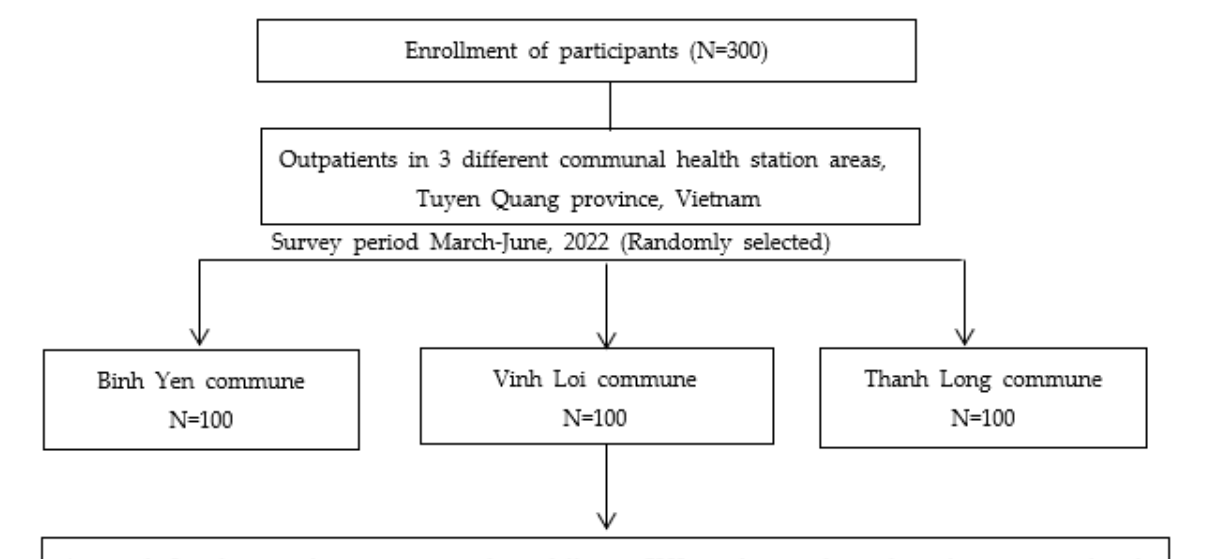
Figure 1. Flow chart diagram of the study design and participants for three commune areas in the Tuyen Quang province of Vietnam. Table 2. Demographic characteristics of the research participants.